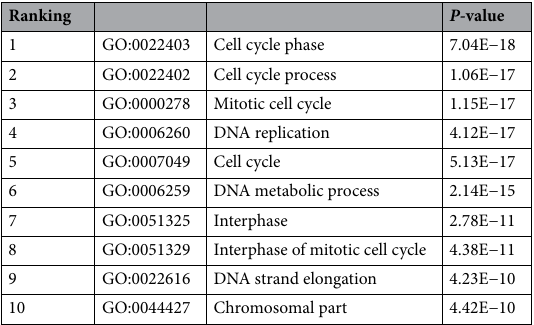
Table 1. Gene ontology assessment of differentially expressed genes from microarray data comparing control and BEX2-knockdown HuCCT1 cells analyzed by ToppGene (https ://toppg ene.cchmc